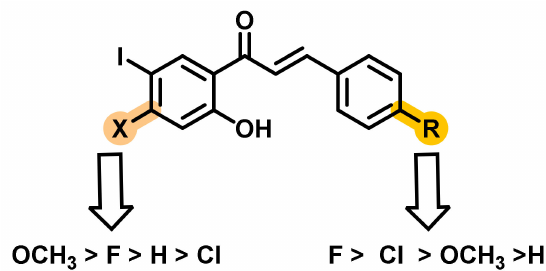
Figure 6. Chalcone derivatives with simple substitutions by Mphahlele et al.